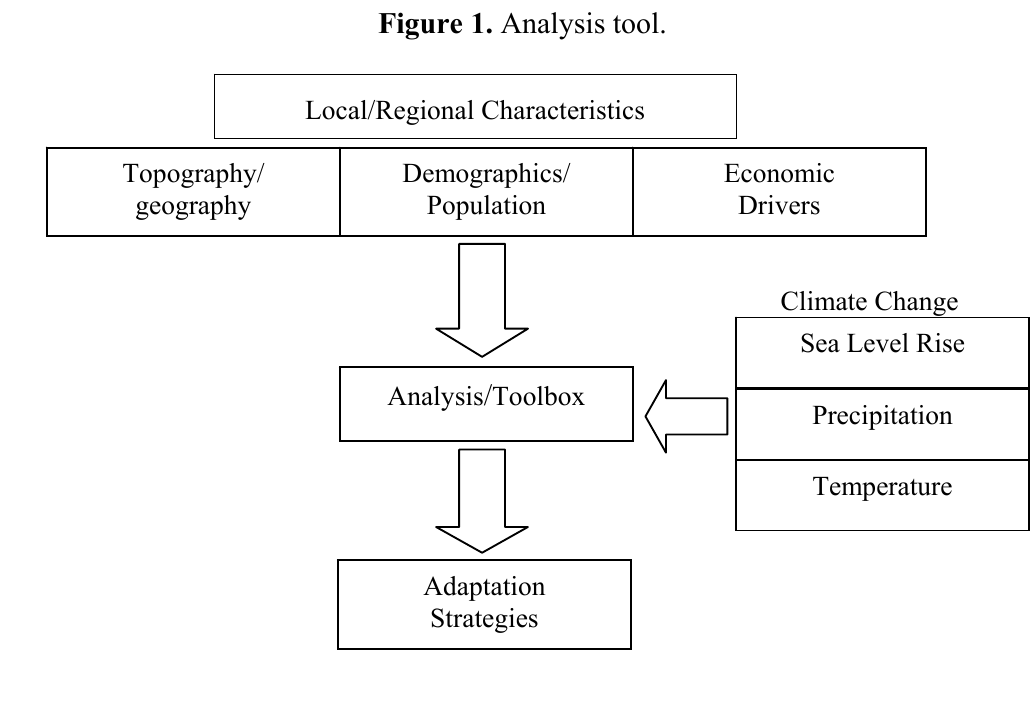
Figure 1. Analysis